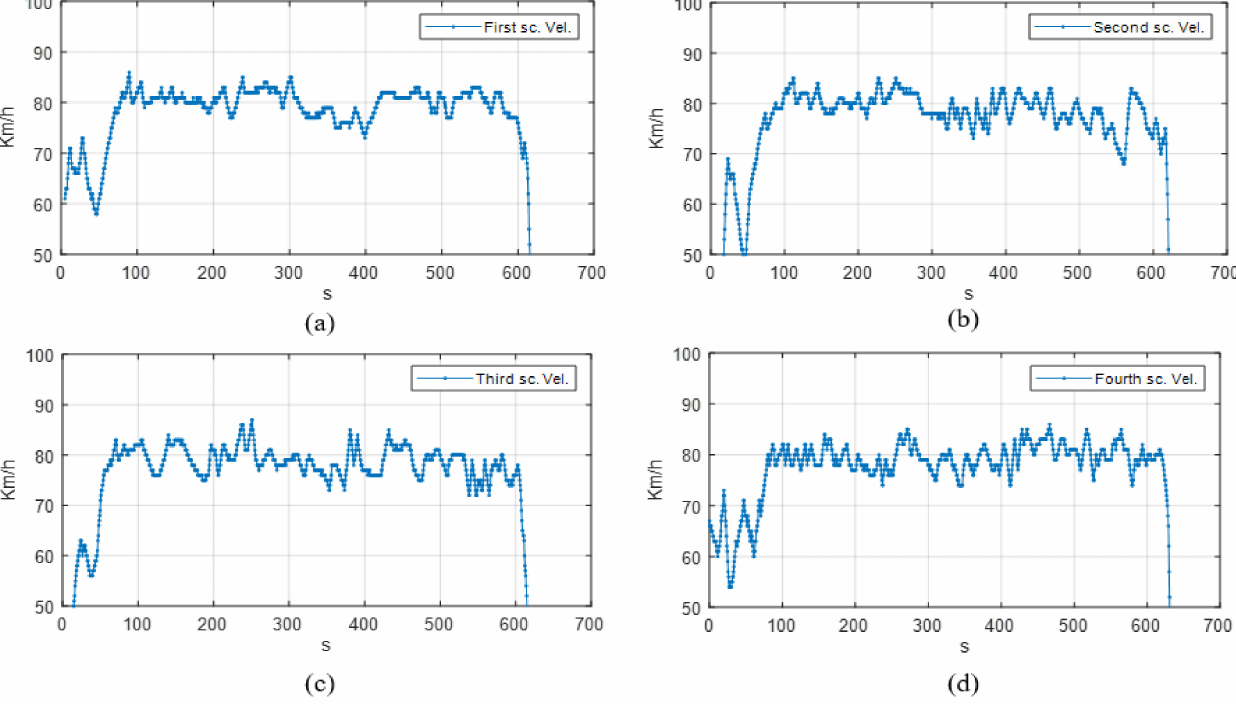
Figure 13. Vehicle speed of all scenarios. ( a ) Scenario 1. ( b ) Scenario 2. ( c ) Scenario 3. ( d ) Scenario